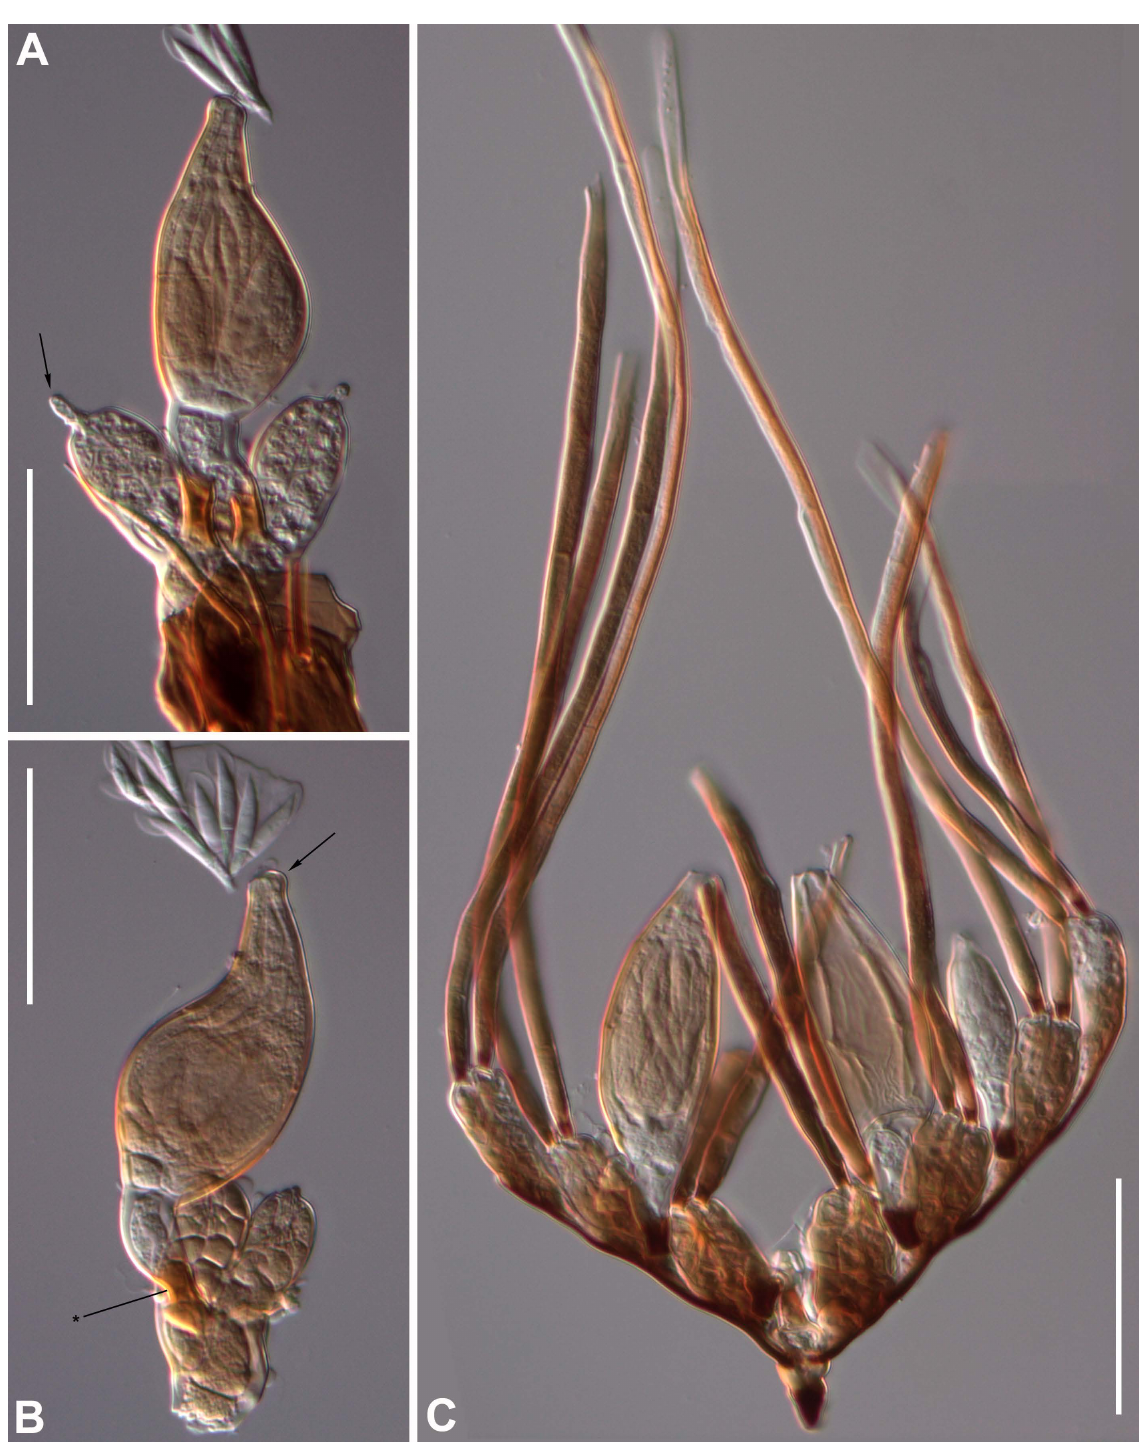
Fig. 80. Monoicomyces spp. A – B . M. athetae Thaxt. Ascospores released from perithecia can be seen. A . Mature thallus showing a rudimentary secondary appendage (arrow). B . Mature thallus showing stalk cell of perithecium narrowing and darkening near the base (*) and rounded protuberance on one side of the perithecial tip (arrow). – C . M. bolitocharae T.Majewski. Mature thallus. Scale bars: 50 µm. Photographs from slides ZMUC C-F-123167 (A–B), ZMUC C-F-123746